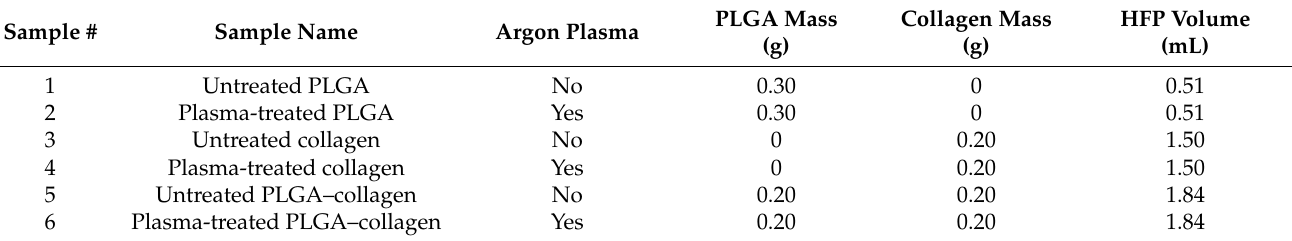
Table 1. Compositions of the samples prepared by solvent